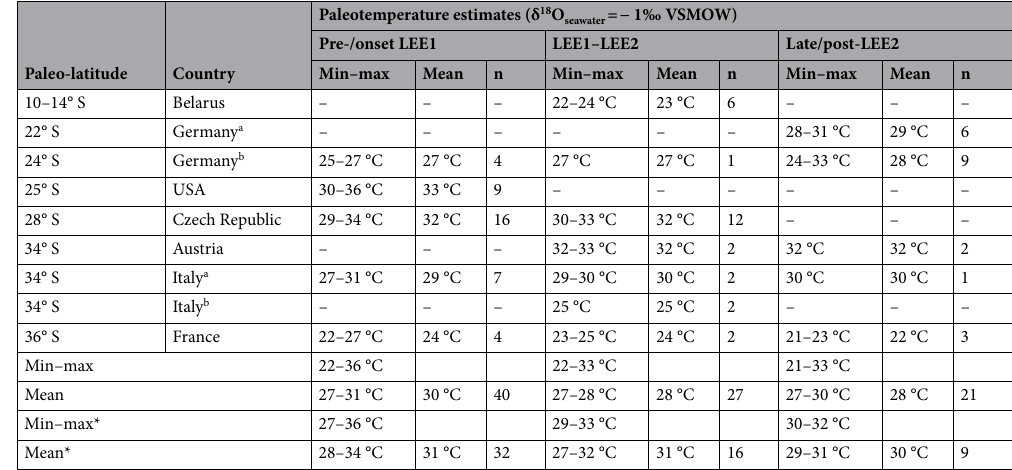
Table 1. Calculated regional paleotemperature ranges and mean values for each paleolatitude/country and biozone. Pre-/onset LEE1 = kockelianus Biozone; LEE1–LEE2 = ensensis Biozone; late/post-LEE2 = hemiansatus Biozone; Germany: a = Blauer Bruch, b = Eifel; Italy: a = ZMB section, b = Val di Collina quarry; min–max* and mean* indicate calculation excluding shallow marine localities: Belarus, Germany b , Italy b and France. Remark: Overall mean SST of the Carnic Alps (summarizing localities in Austria and Italy a ) are 31 °C for the ensensis and hemiansatus